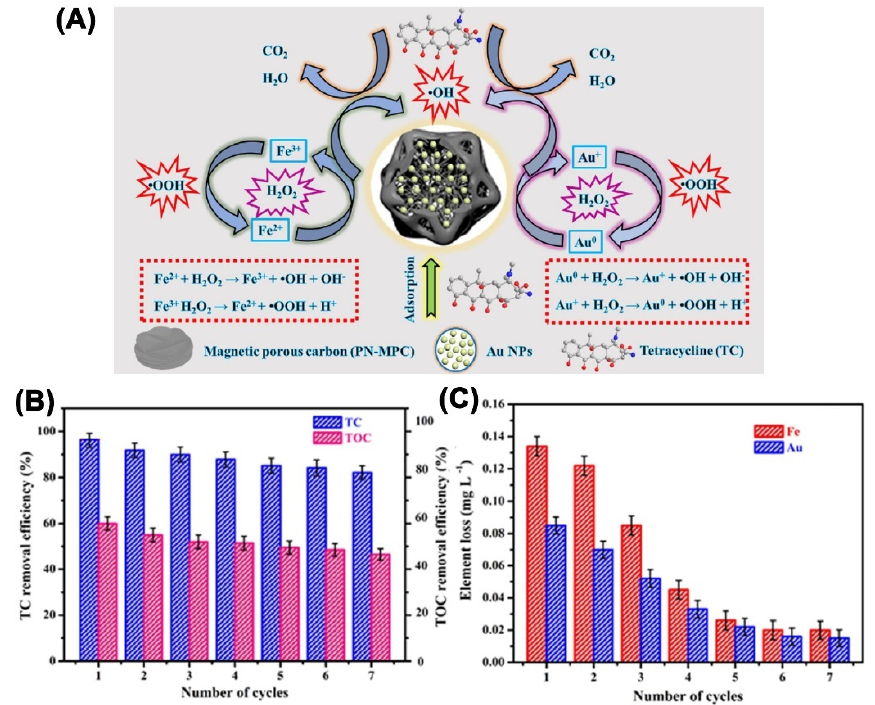
Figure 7. ( A ) Proposed mechanism of catalytic degradation of antibiotics for Au/PN-MPC catalysts; ( B ) removal efficiency of TC; and ( C ) leached iron and Au NPs in seven consecutive runs [86], Copyright 2021 Elsevier.